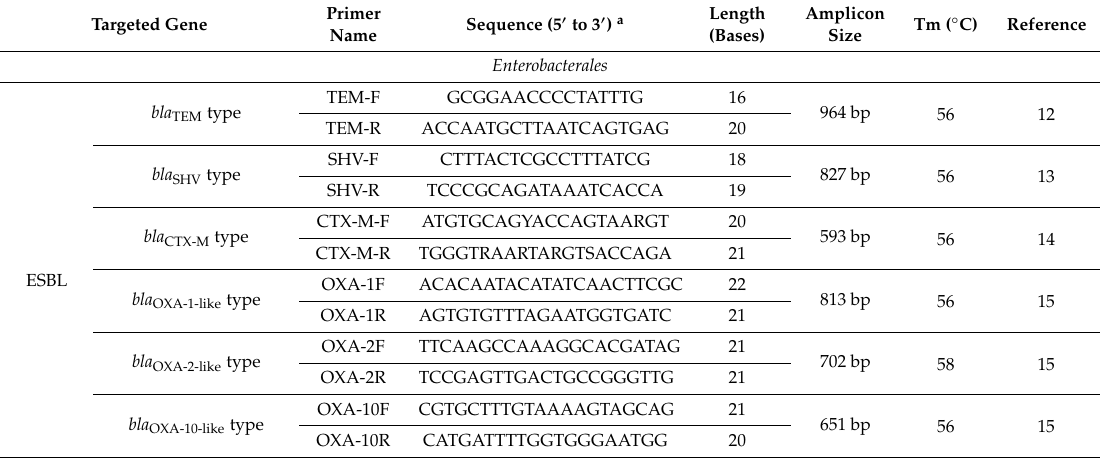
Table 3. Sequences of primers used for PCR for detection of resistance